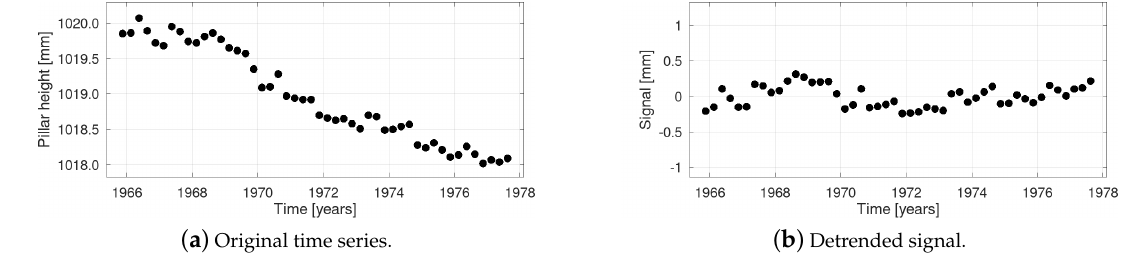
Figure 1. Milan Cathedral time